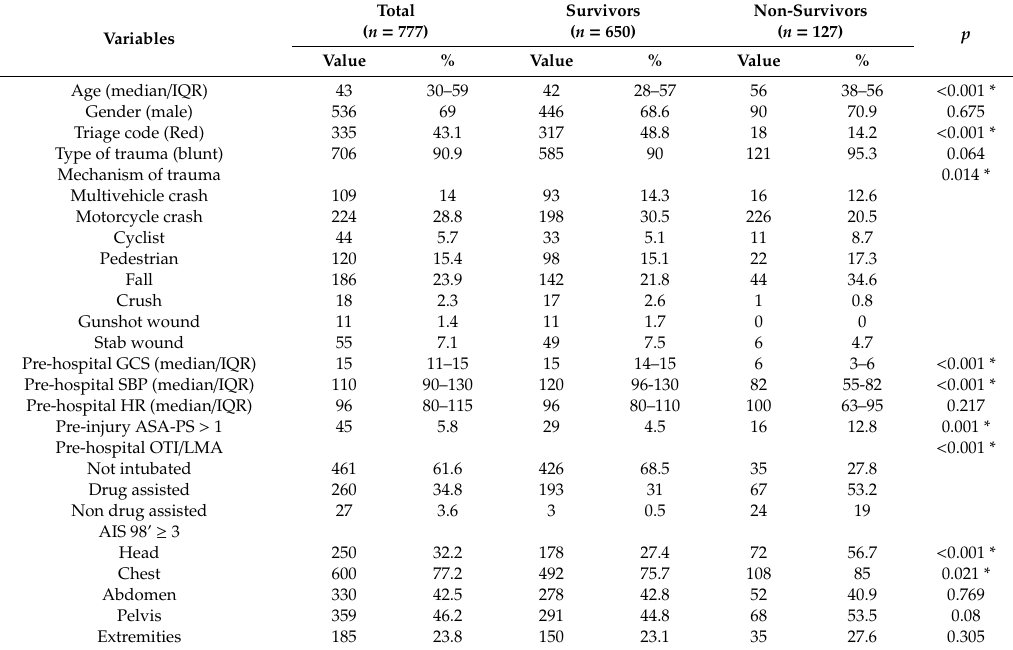
Table 1. Demographic and trauma-related data. Comparison between survivors and